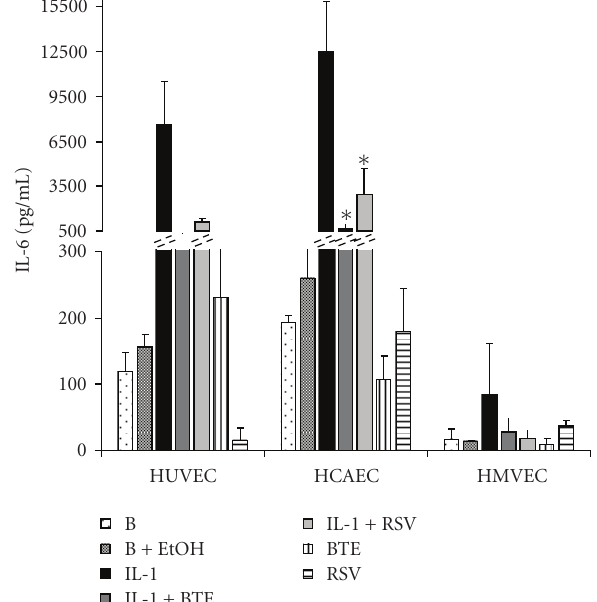
Figure 2: Released IL-6 protein levels as measured by ELISA of supernatants from HUVEC, HCAEC, and HMVEC incubated with IL-1 β (1000 pg/mL) for 24 hours in the absence or presence of BTE (40 μ g/mL) and RSV (40 μ M). Data represent the mean ± SD of three separate experiments. ∗ P < . 05 compared with IL-1 β levels of expression.